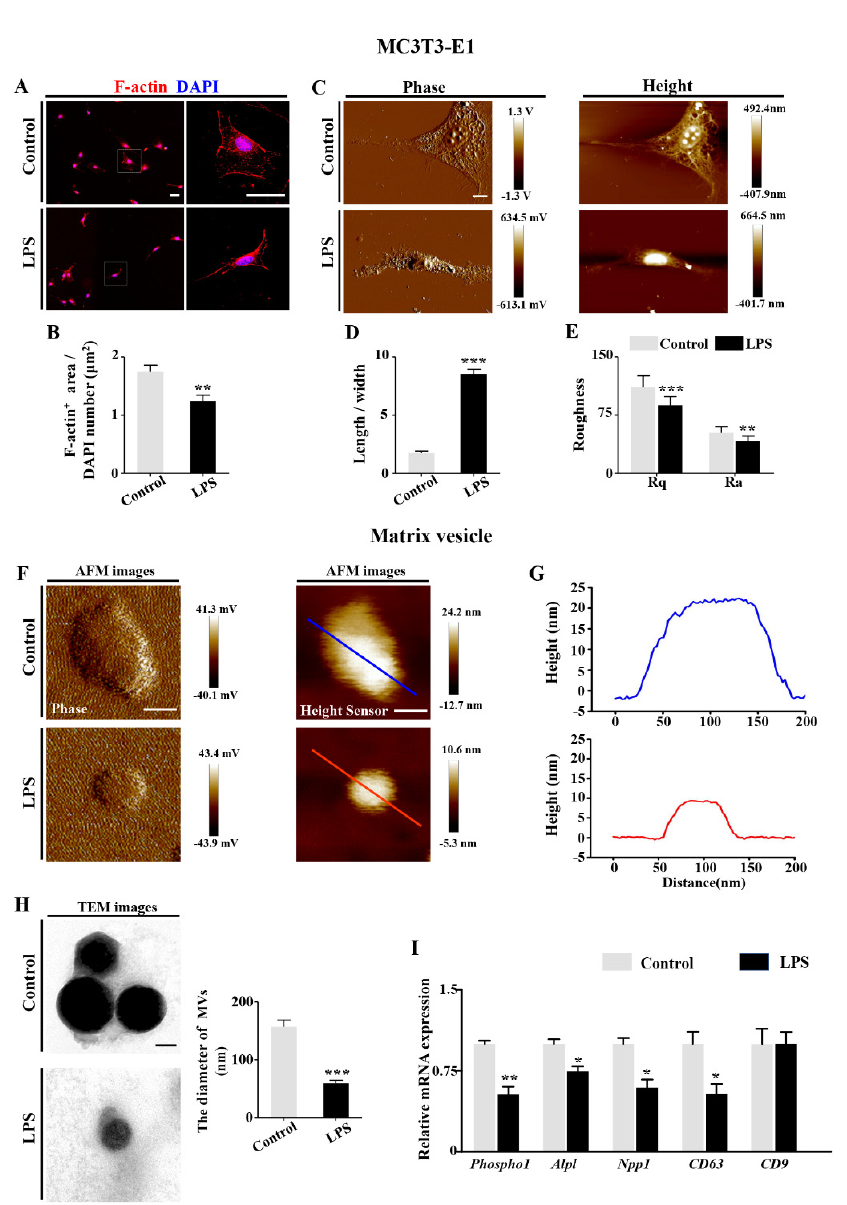
Figure 4. Assessment of the morphology of osteoblasts following LPS treatment. ( A ) Representative images of F-actin staining on 7-day cultured MC3T3-E1 cells of control and LPS-treated groups, counterstained with DAPI. The structures outlined by dotted squares are shown at a higher magnification in the right panels. Negative controls were shown in supplementary material (Figure S7). ( B ) Bar chart showing the ratio of F-actin-positive area/DAPI-positive cell numbers of control and LPS-treated groups. ( C ) Representative AFM phase and height images of MC3T3-E1 cells of control and LPS-treated groups cultured for 7 days. ( D , E ) Bar charts comparing the ratio of cell length to width ( D ), cell surface arithmetic average roughness (Ra) and root-mean-square roughness (Rq) ( E ) between control and LPS-treated groups. ( F ) Representative AFM phase and height sensor images of MVs collected from 7-day cultured MC3T3-E1 cells of control and LPS-treated groups. ( G ) Two-dimensional cross-sections of MVs taken across the maximum height of each vesicle. The lines in ( F ) show the direction of each cross-sectional measurement. ( H ) Representative TEM images of MVs secreted from MC3T3-E1 cells of control and LPS-treated groups. Bar charts at right panel show the comparison of diameter of MVs between control and LPS-treated groups. ( I ) qPCR data showing the expression of Phospho1 , Alpl , Npp1 , CD63 , and CD9 of control and LPS-treated groups. Scale bars = 50 μ m in ( A ), 10 μ m in ( C ); 50 nm in ( F and H ). (** p < 0.01, *** p < 0.001)